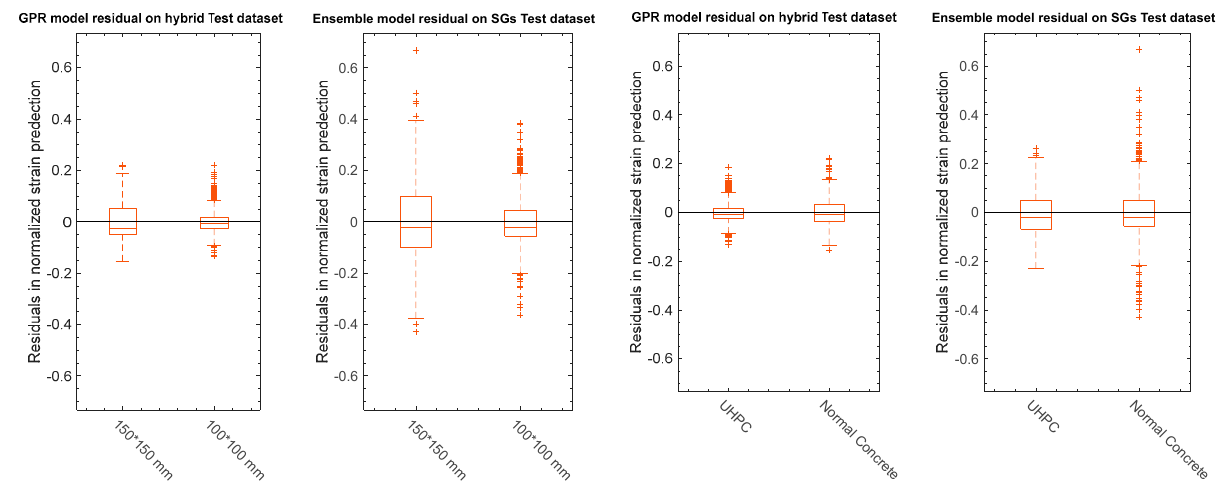
Figure 18. Box plot visualization of summary statistics for residuals in normalized predictions for each concrete type and cross-sectional area.